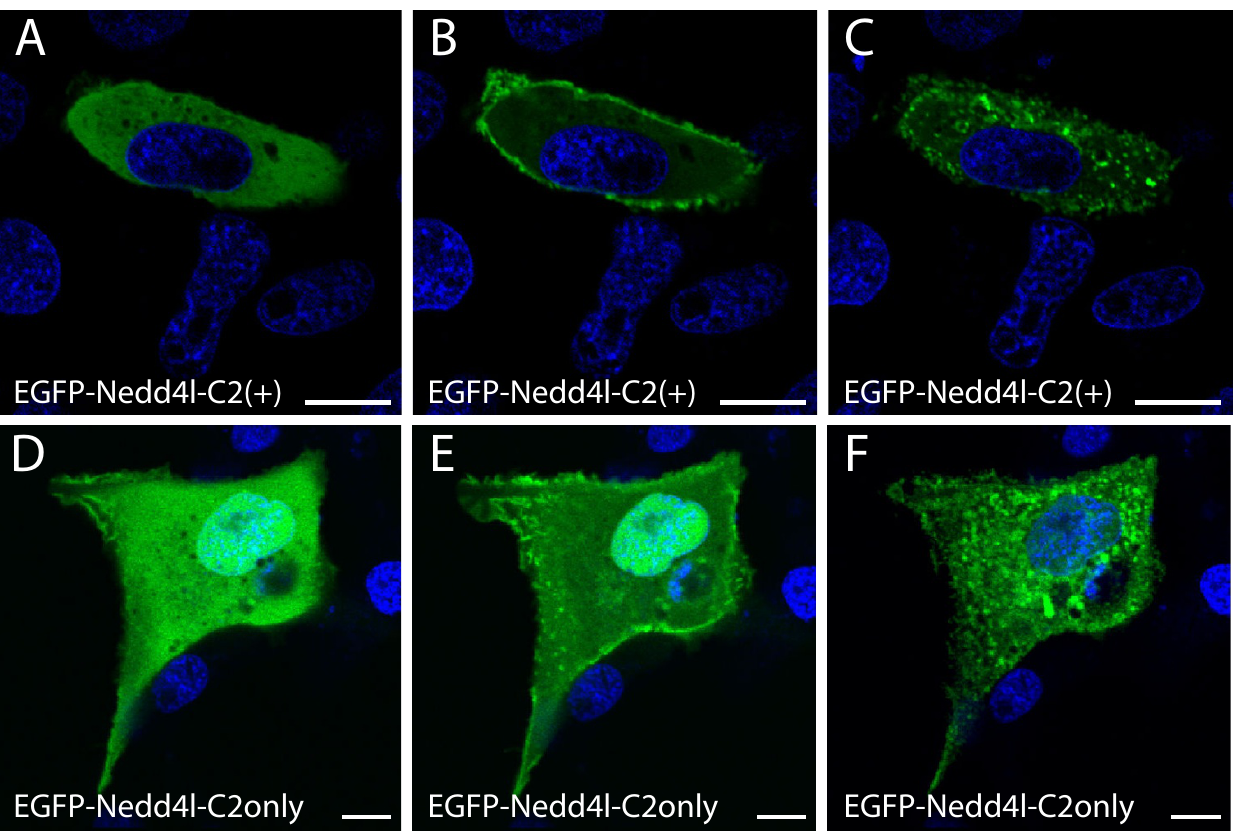
C2(+) (A-C) or EGFP-C2(only) (D-F) that were incubated in 1.97 Ca 2+ . Images were acquired at 0 (A), 40 (B), 90 (C), 0 (D), 10 (E), and 30 (F) seconds after a 10 uM ionomycin addition. Both EGFP-NEDD4L-C2(+) and EGFP-C2(only) respond to the Ca 2+ stimulus by first mobilizing to the plasma membrane and then relocalizing to numerous small intracellular structures. Scale bars are equivalent to 10 μ